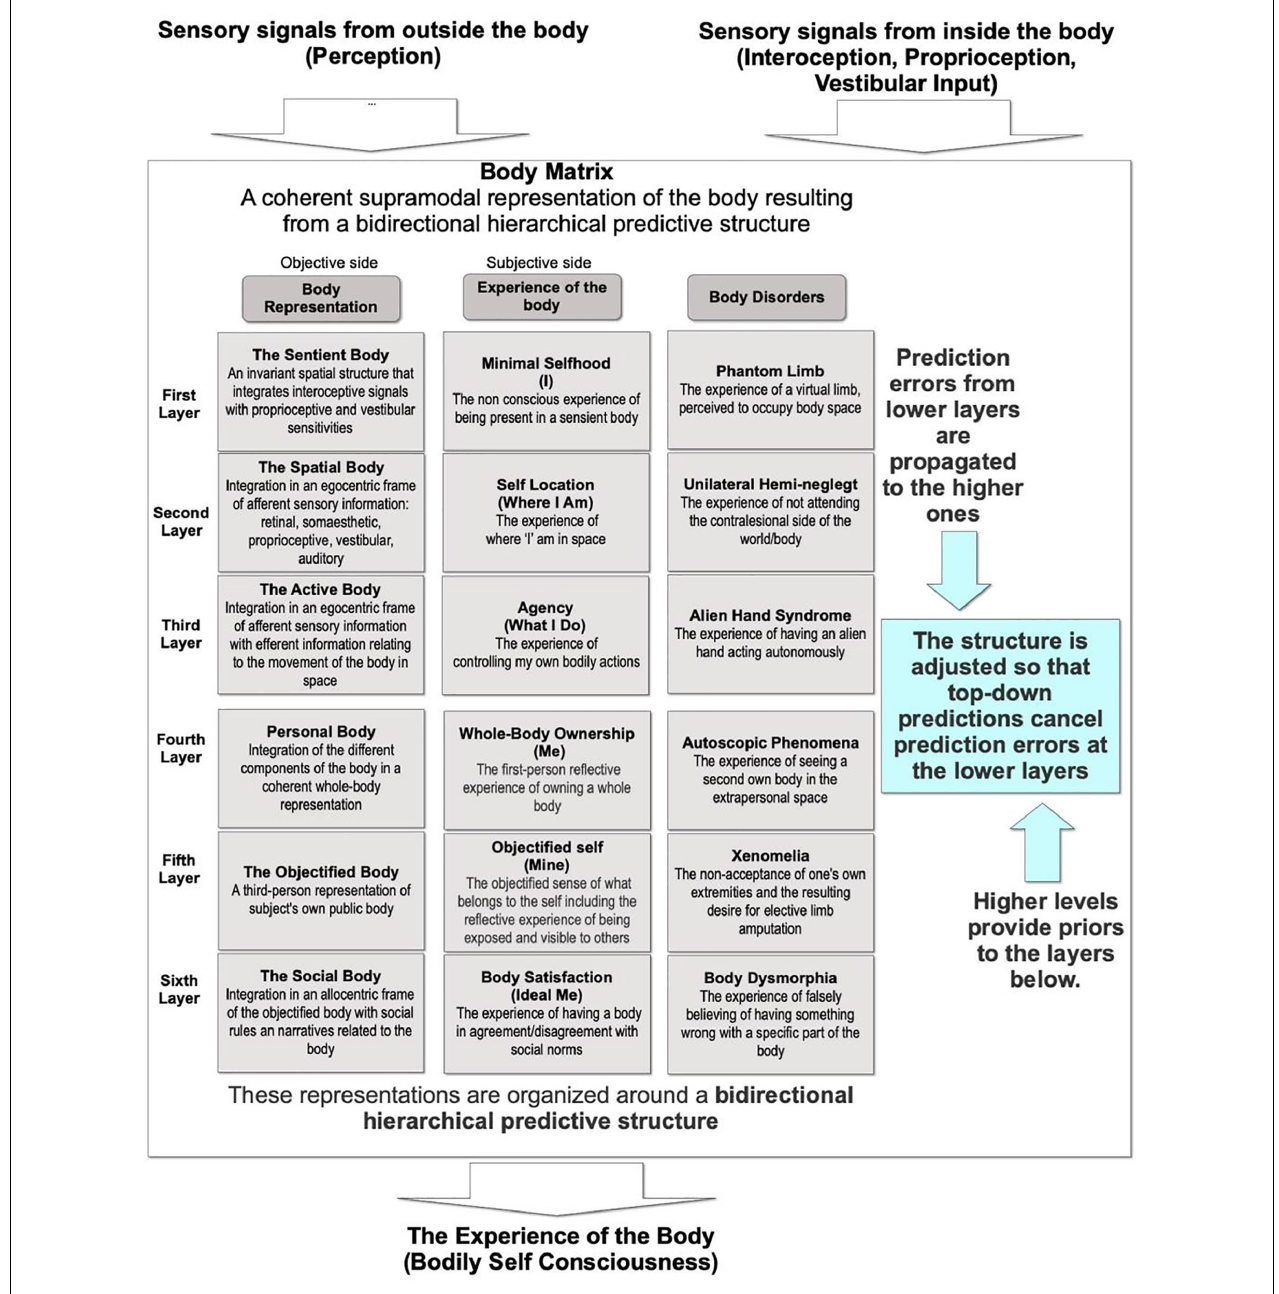
FIGURE 1 | The body